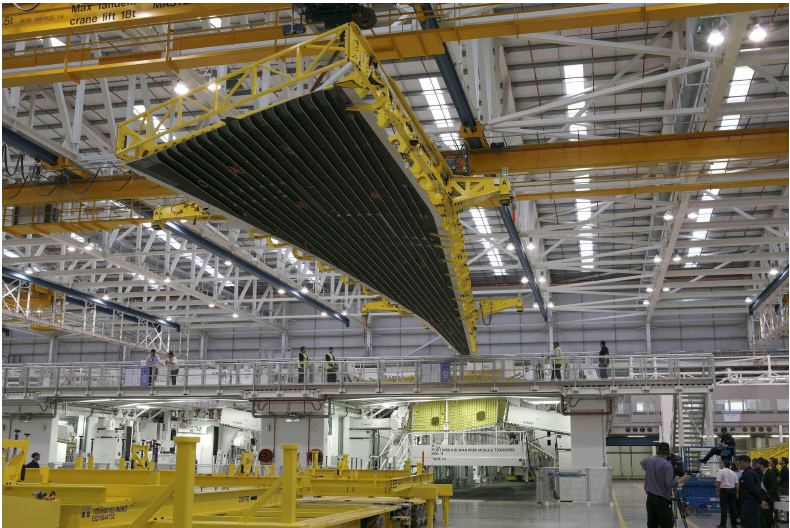
Figure 1. Assembly jig for the A350 XWB wing cover as an example for current approaches to assembling compliant structures